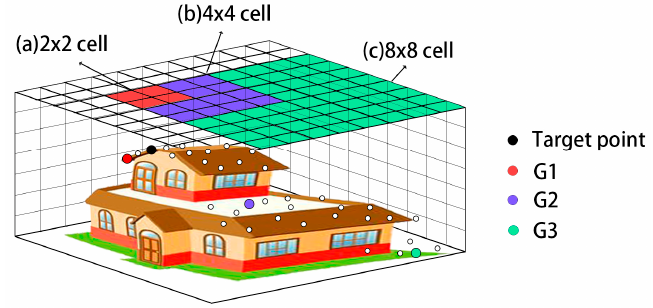
Figure 6. The schematic diagram of multi-scale comparison-based DTM generation method.